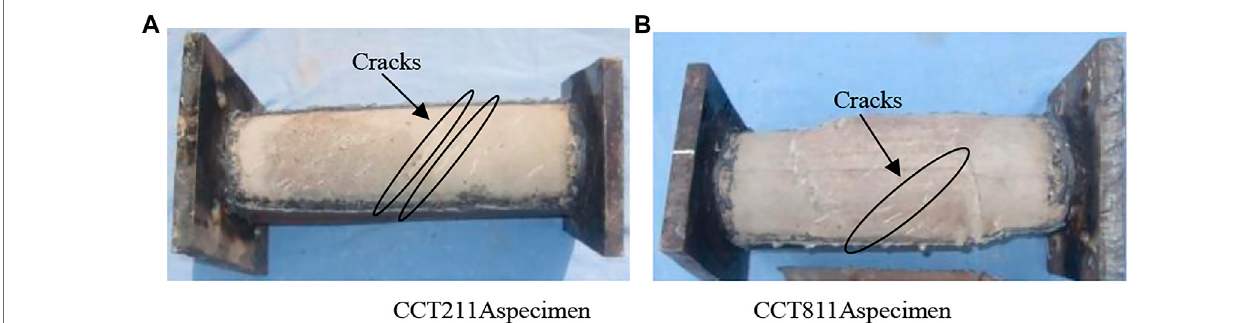
FIGURE 5 | Failure characteristics of concrete. (A,B) Crack location of concrete.